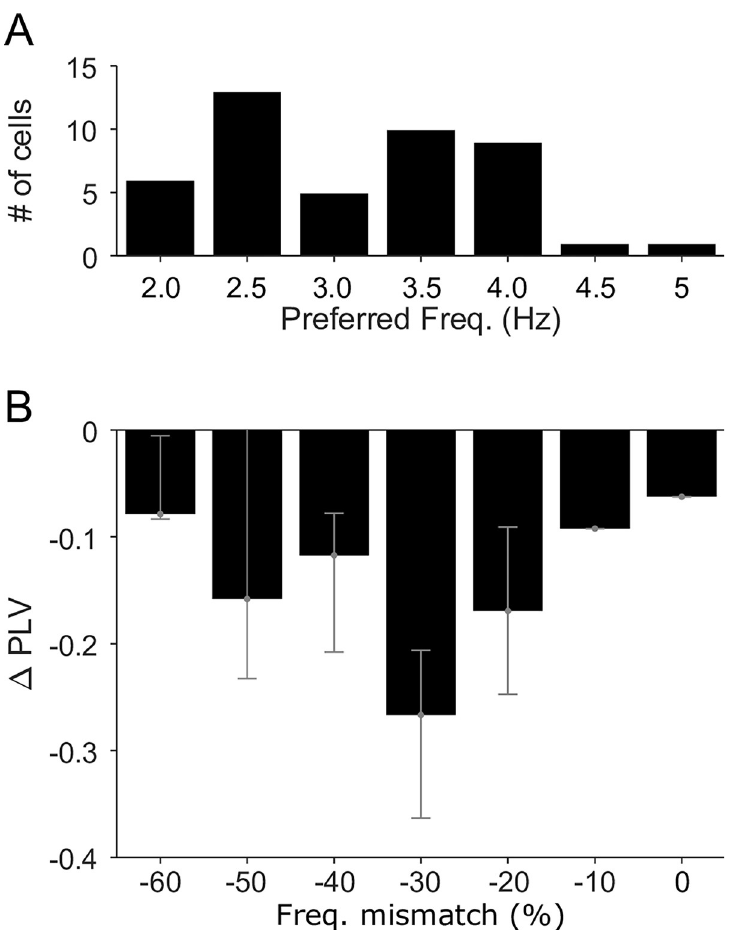
Fig 5. Preexisting frequency preference determines the effects of tACS. (A) Histogram of narrowband preferred frequency for the 47 V4 neurons with significantly decreased entrainment during 5 Hz tACS. (B) Changes in these neurons’ PLV as a function of the difference between their narrowband preferred frequency and the 5 Hz tACS frequency. Note the qualitative similarity to the flank of Fig 4C. See S1 Data for numeric values. PLV, phase-locking value; tACS, transcranial alternating current